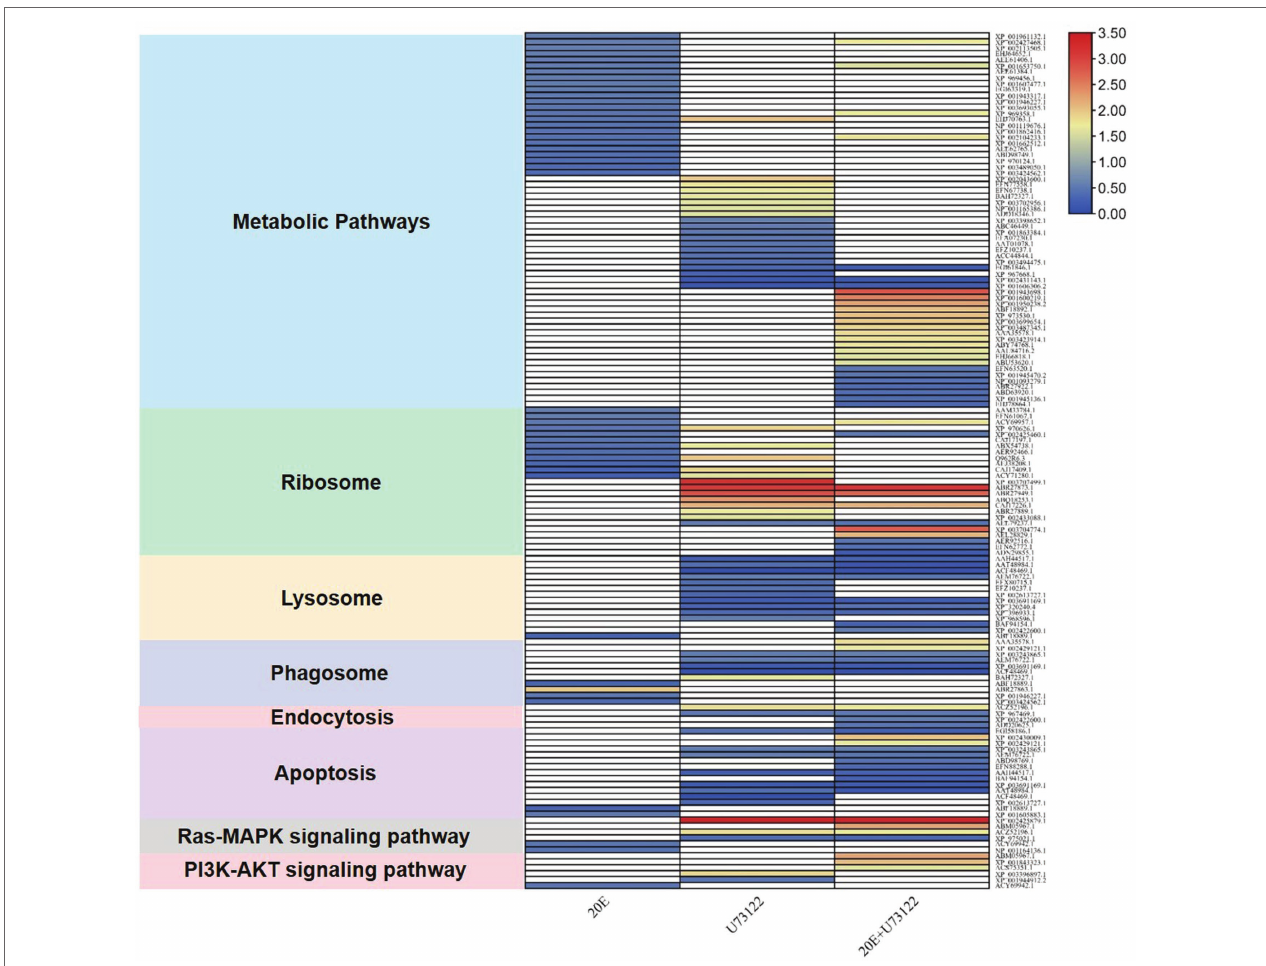
FIGURE 4 | Enrichment analysis of DEGs in the KEGG pathway after treating A. lucorum with 20E, U73122, and 20E +